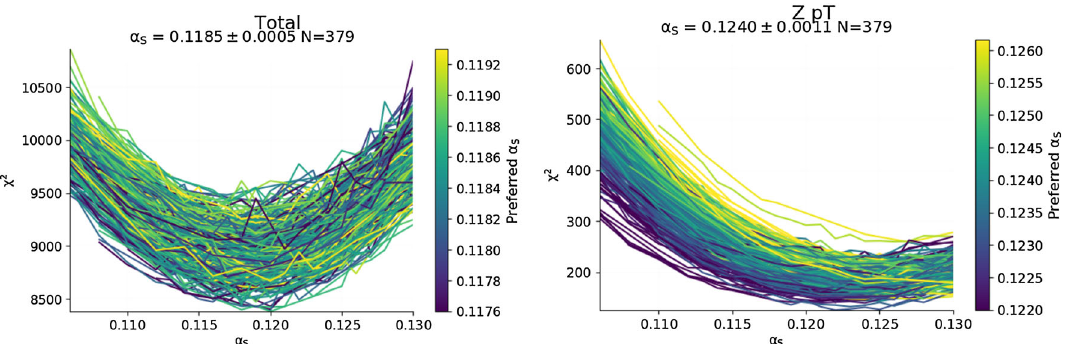
Fig. 1 The χ 2 profiles for each of the data replicas used for the NNLO determination of α s ( m Z ) of Ref. [25]. Both the profiles for the total dataset (left), and for the Z p T distribution (right) are shown